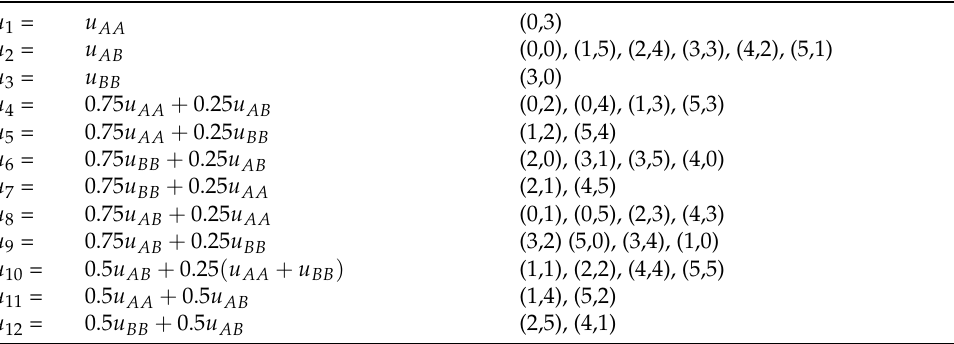
Table 1. Possible different values of the interaction energy between a pair of neighboring particles and the pairs of orientations of a given energy for the separation vector vecr = ( 1,0 )